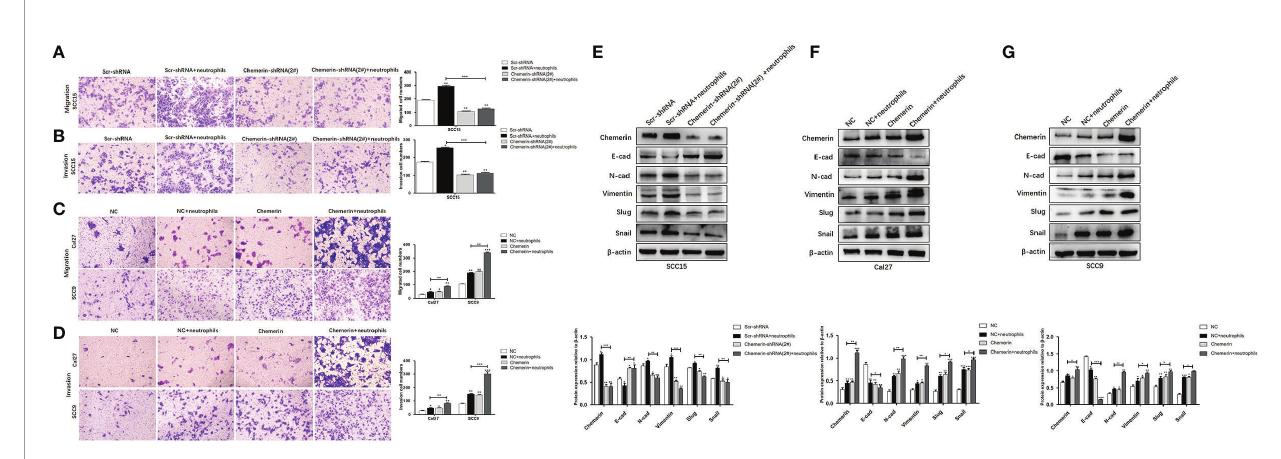
FIGURE 6 | Neutrophils promote migration, invasion and EMT of OSCC cells through Chemerin. (A, B) Transwell and invasion assays showed migration and invasion of SCC15 cells in the Scr-shRNA, Scr-shRNA + neutrophils, Chemerin-shRNA (2#), and Chemerin-shRNA (2#) +neutrophils groups. (C, D) Migration and invasion assay of Cal27 and SCC9 cells in NC, NC + neutrophils, Chemerin, and Chemerin + neutrophils groups. (E – G) Western blot of Chemerin, E-cadherin, N-cadherin, Vimentin, Slug and Snail. All data were presented as mean ± SD values from three independent experiments, each performed in triplicates (* P < 0.05; ** P < 0.01; *** P <